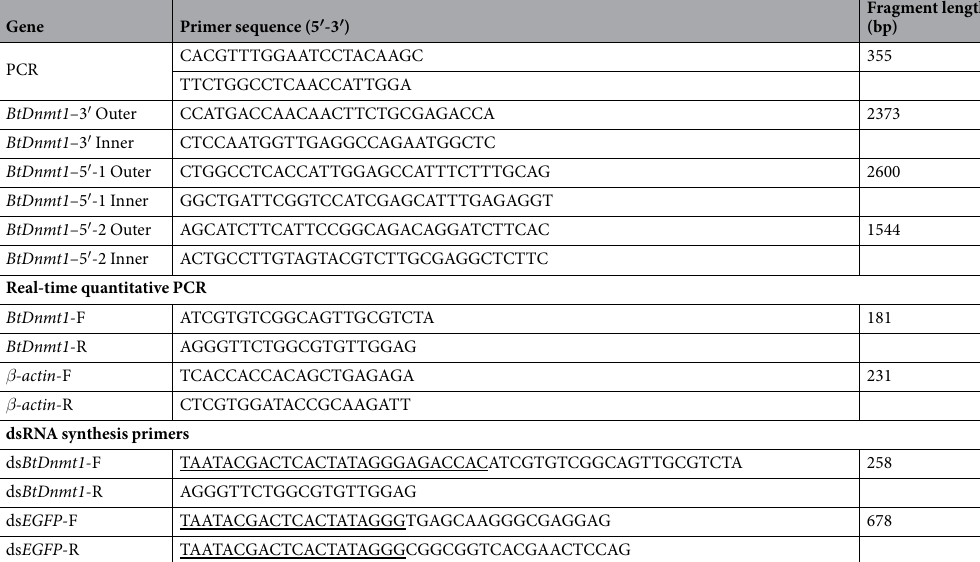
Table 1. Primer sequences used for cDNA cloning, real-time quantitative PCR and dsRNA synthesis. Primer sequences plus T7 promoter sequences (underlined) are shown for production of the dsRNA transcription templates.